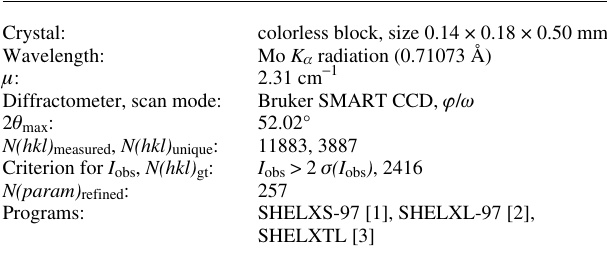
Table 1. Data collection and handling.